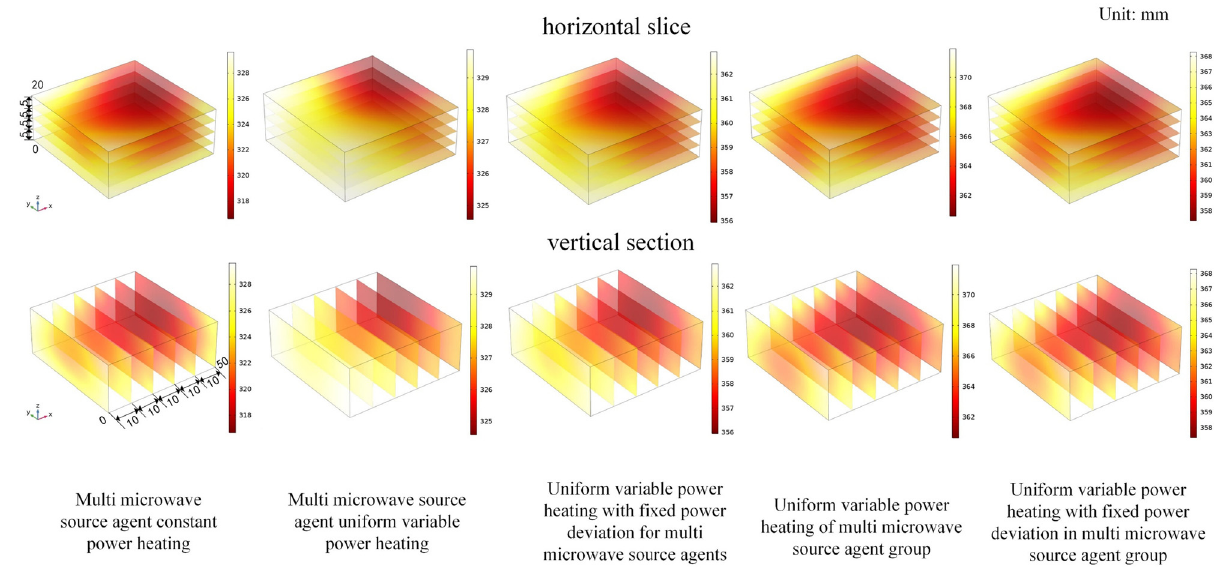
Figure 12: Heating e ff ect section of the fi ve